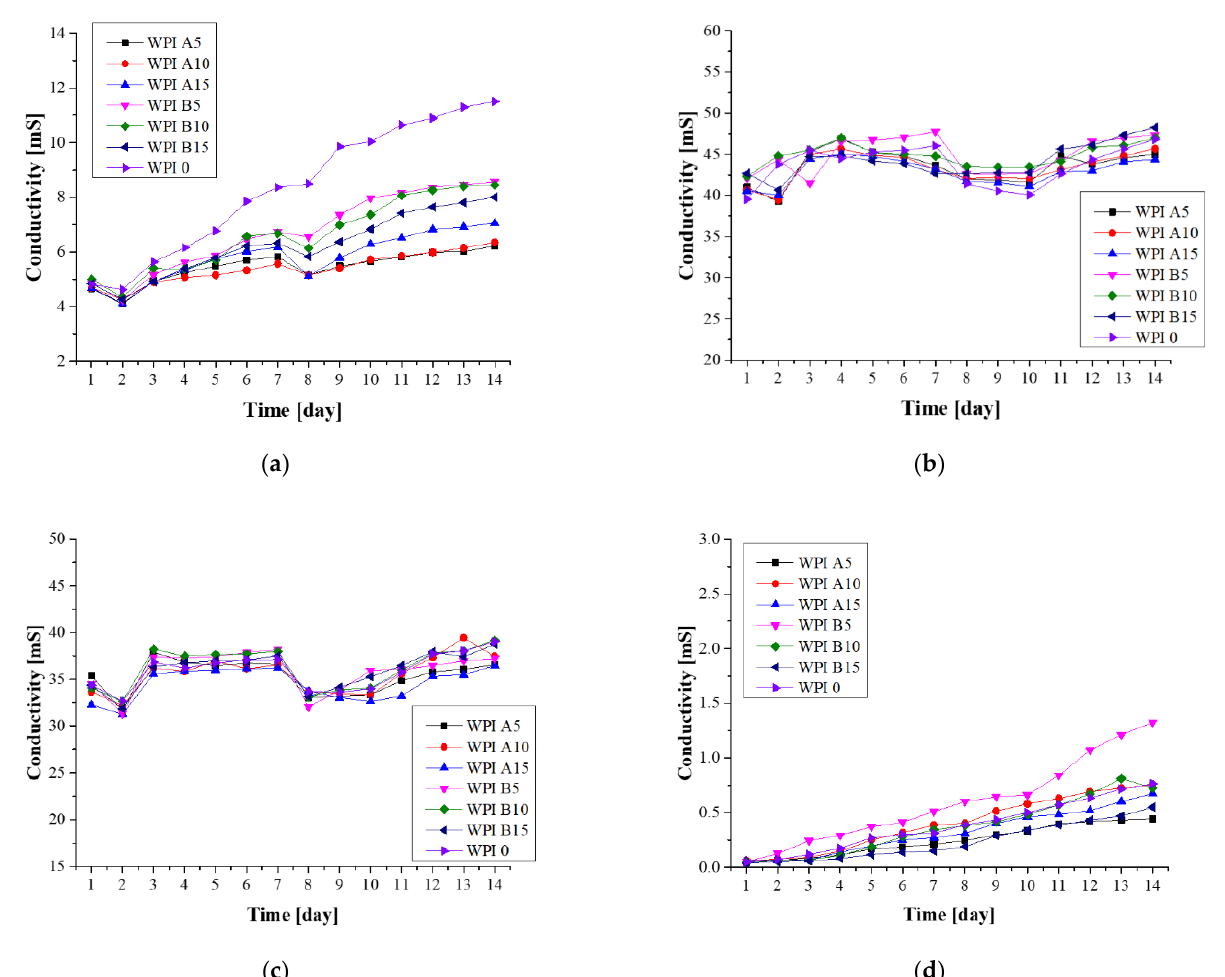
Figure 3. Conductivity analysis of hydrogels during a 14-day incubation in fluids simulating the biological environment: ( a ) incubation in artificial saliva; ( b ) incubation in SBF; ( c ) incubation in Ringer’s fluid; ( d ) incubation in distilled water.